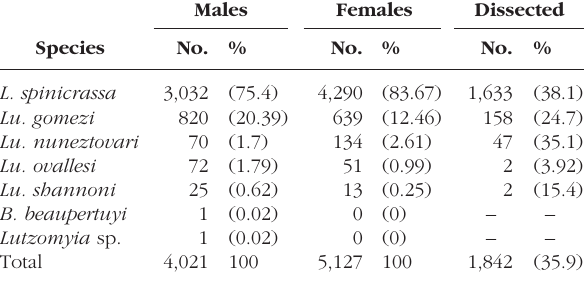
Table I. – Sandfly species composition, abundance and search for Leishmania spp. in Catarnica, Táchira State,